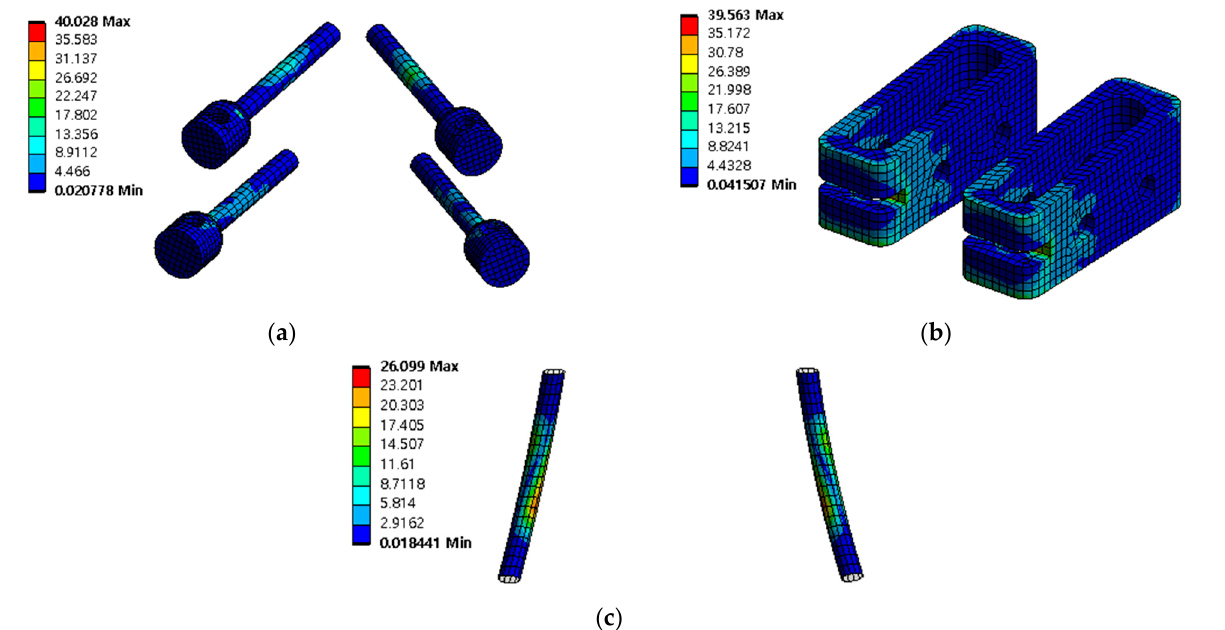
Figure 13. Equivalent stress ( σ ) distribution of spinal implants at porosity 50% in extension: ( a ) pedicle screw; ( b ) spinal cage; and ( c ) spinal rod.